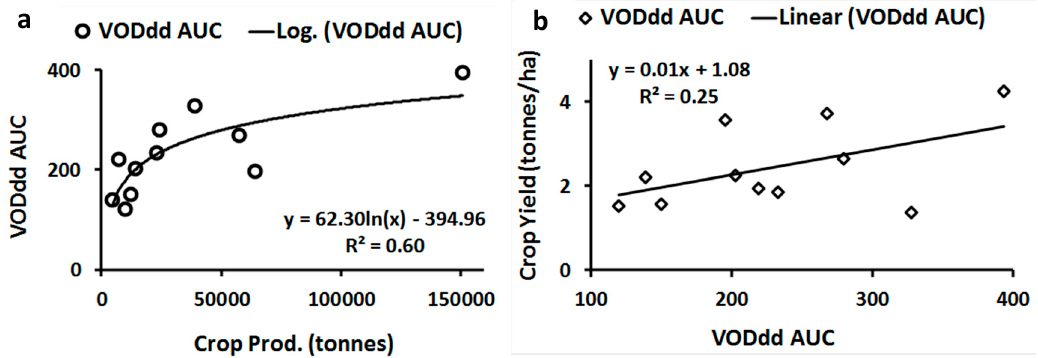
Figure 12. Relationships between area under VOD dd curve and statistical data for ( a ) crop production and ( b ) crop yield at the woreda level in the Amhara Region in Northwestern Ethiopia for 2014. Both fits are significant at p < 0.01.